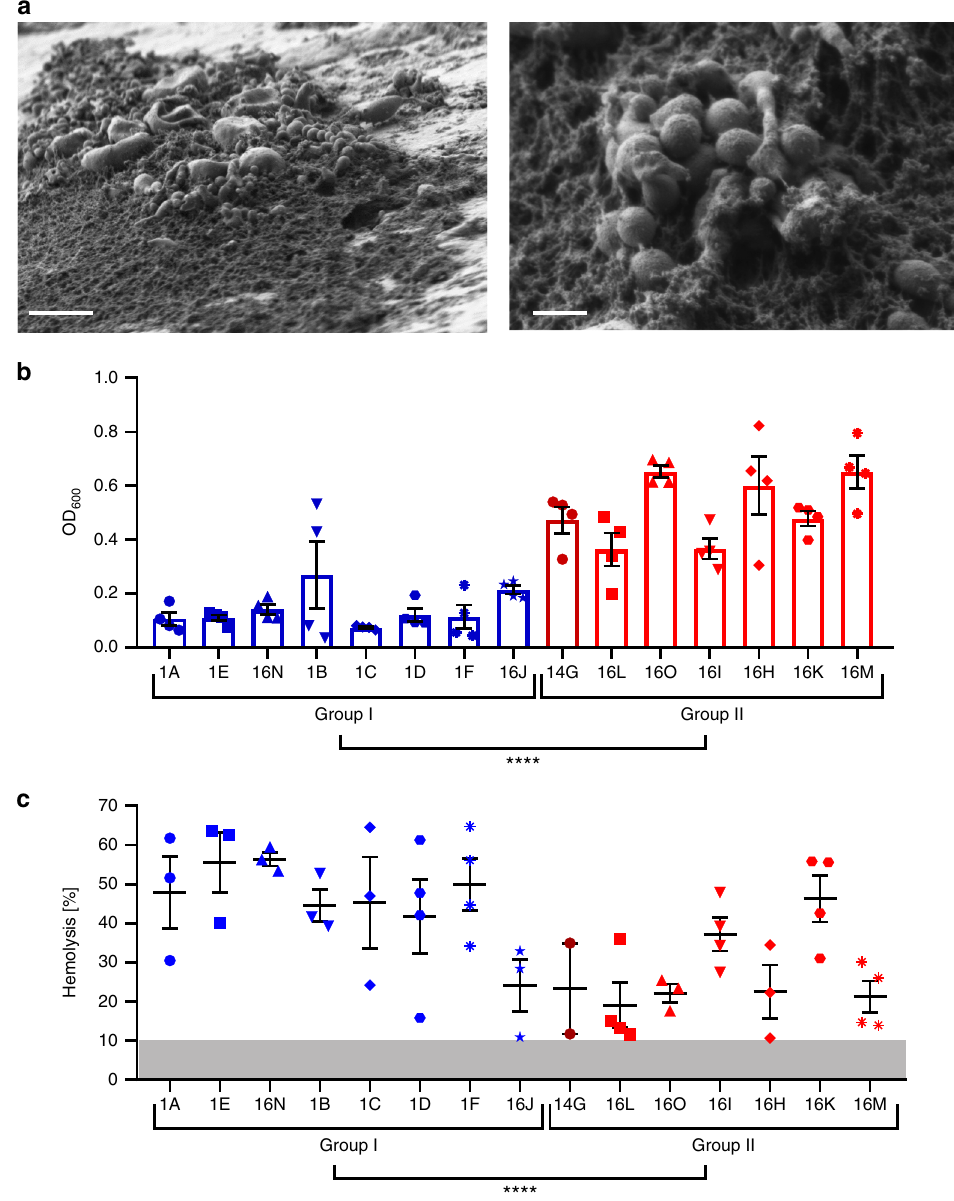
Fig. 3 Bio fi lm formation and hemolysis of the clinical ST378 isolates. a FEM pictures of the bio fi lm formed on the patient ’ s electrode. Scale bar left 5 µ m and right 1 µ m. b Quantitative in vitro bio fi lm assay of ST378 isolates. Isolates were grown in TSB 0.5% glucose in 96-well plates, and the washed bio fi lms were quanti fi ed by OD 600 measurement. Statistical signi fi cance between the two groups was determined by Welch's t test ( N = 60 t (46.40) = − 10.513, P = 7.3 × 10 -14 ). c Relative lysis of sheep blood erythrocytes by ST378 isolates indicated in percentages. The gray zone indicates the detection limit of 10% lysis below which the values were not included. Statistical signi fi cance between the two groups was determined by Welch's t test ( N = 50 t (47.92) = 4.2857, P = 8.7 × 10 -5 ). Group I and group II isolates are indicated in blue and red, respectively. Dark red indicates the clinical isolate retrieved from the blood culture. Averages with standard error of mean of at least three replicates are shown. **** P <